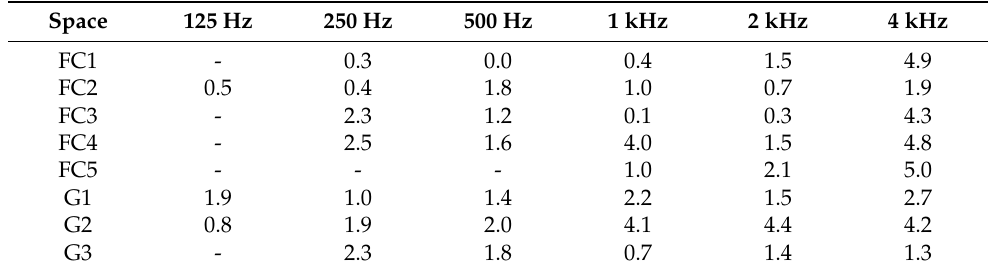
Table 6. Curvature parameter C , %.